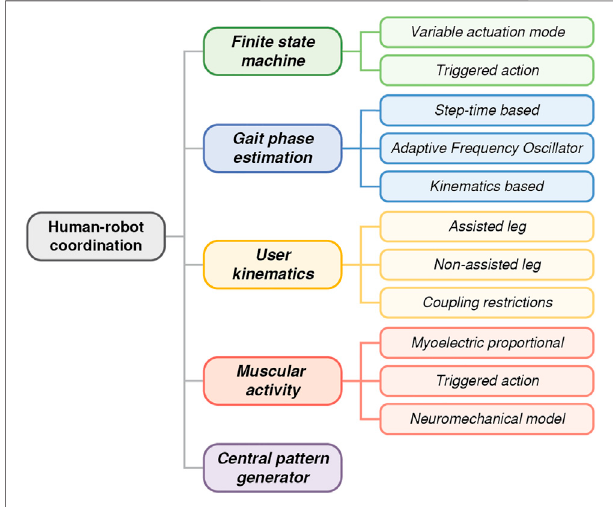
FIGURE 2 | Classi fi cation of the different kinds of human-robot coordination strategies identi fi ed throughout the systematic